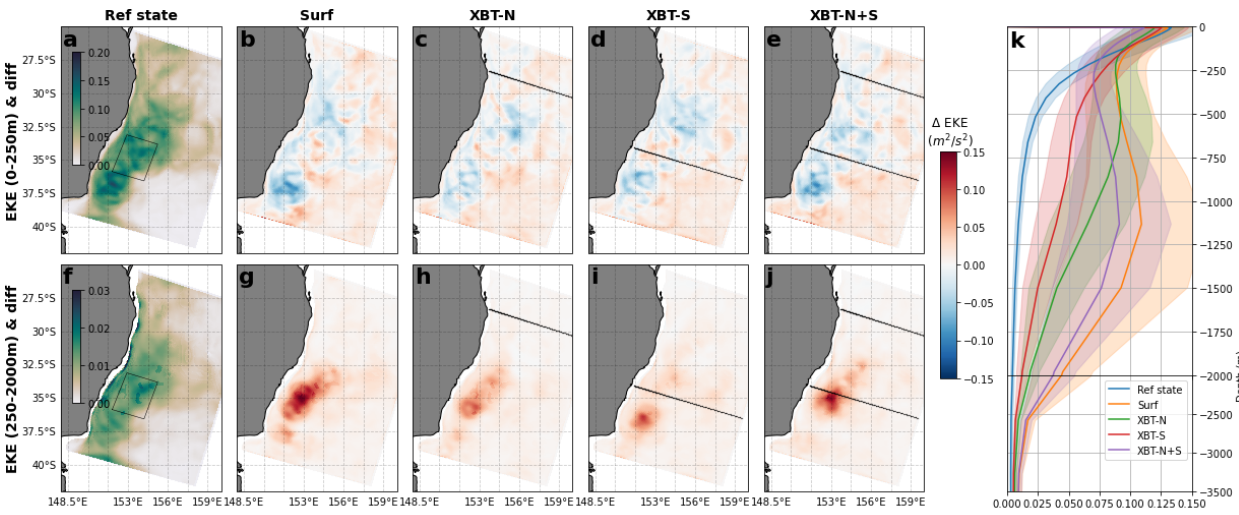
Figure 3. The time-mean eddy kinetic energy (EKE) is shown as the average over the top 250m for (a) the Ref state, and the difference from this for the (b) Surf, (c) XBT-N (d) XBT-S, and (e) XBT-N+S OSSEs and as the average over 250–2000m for (f) the Ref state and the difference from this for the (g) Surf, (h) XBT-N (i) XBT-S, and (j) XBT-N+S OSSEs. In (k) , the vertical profile of the EKE, spatially averaged over the high eddy variability region (box shown in panels a and f ), is shown for each OSSE. The shaded regions designate a range of plus and minus 1 standard deviation in spatial mean EKE at that depth for that OSSE. The XBT-N and XBT-S transect locations are marked in the respective panels. Axes with latitudes are labelled ◦ S, and axes with longitudes are labelled ◦